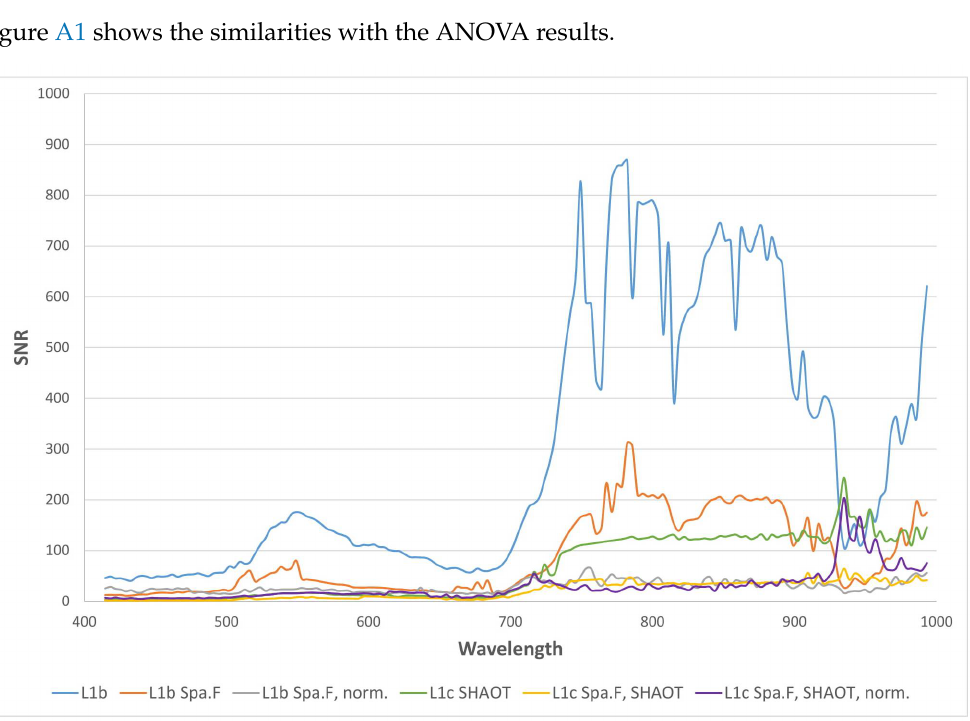
Figure A1. SNR (Signal to Noise Ratio) computed for one flight